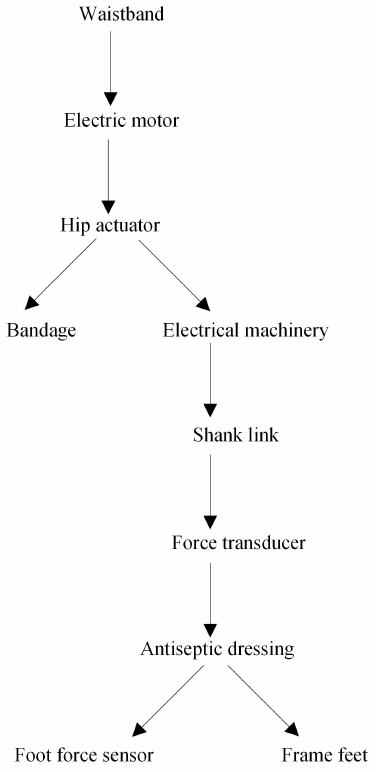
Fig. 6 “Humanoid Robotics ” ontology O 6